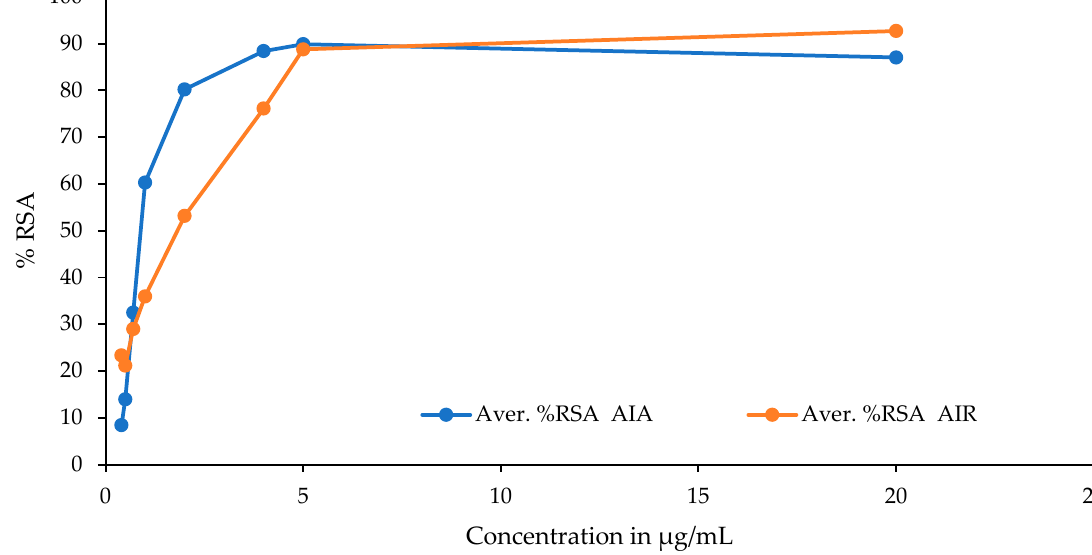
Figure 1. Graph of % free radical scavenging activity of DPPH by the extracts vs. concentration of sample extracts.